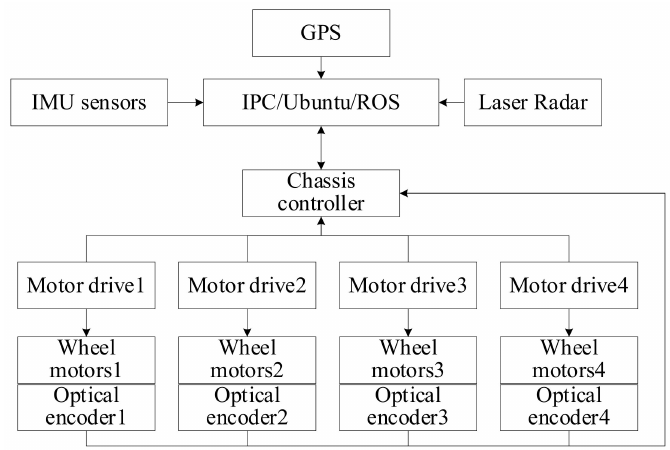
Figure 3. Chassis control system architecture for orchard